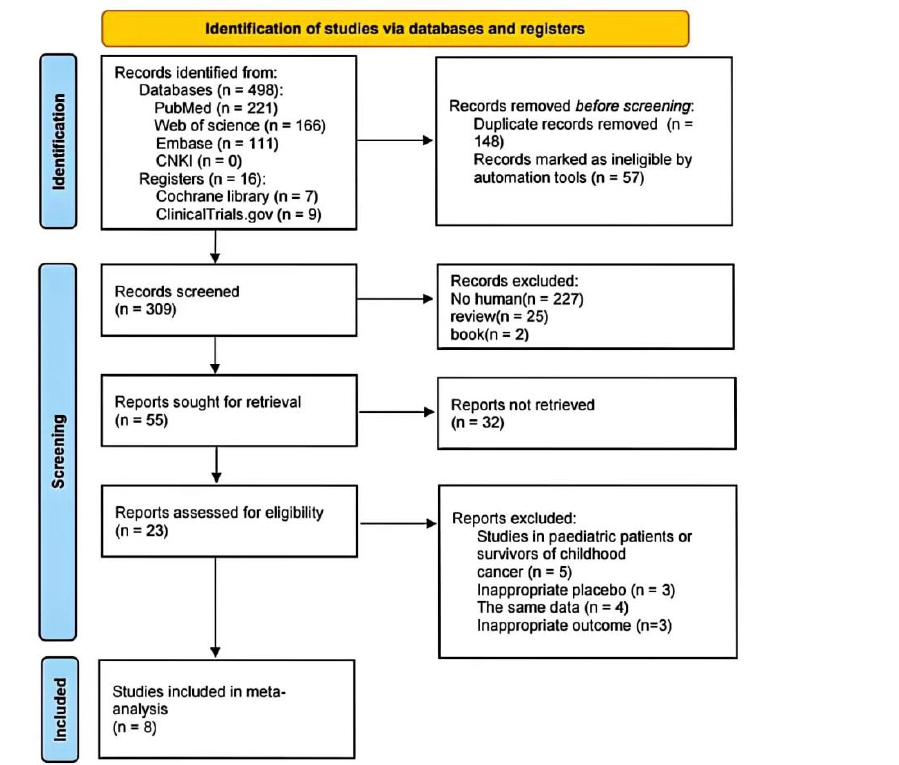
Figure 1. PRISMA 2020 flow diagram for new systematic reviews which included searches of databases and registers only.